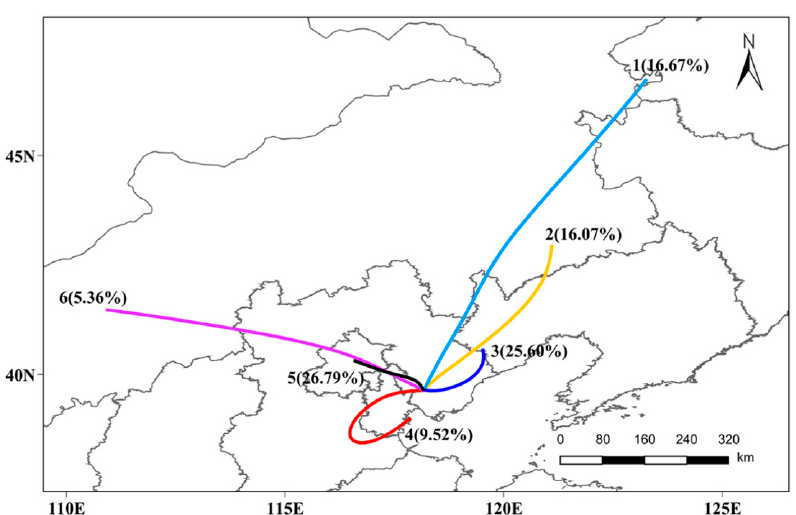
Figure 7. Backward trajectory clustering of air masses during the Spring Festival in 2020.